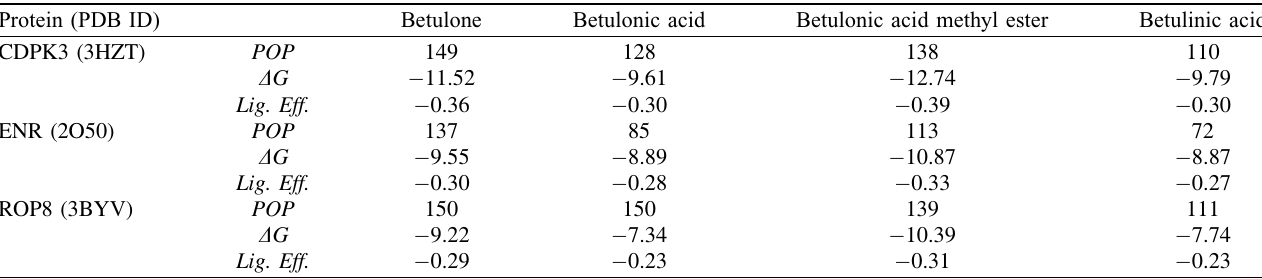
Table 4. Population, free energy of binding, and ligand ef fi ciency of the three re-docked ligand-complexes. Free energy of binding ( D G ) is expressed in kcal/mol. POP stands for cluster population. Ligand ef fi ciency ( Lig. Eff. ) is an AutoDock Tools computed quantity. The lower the value, the better the complex.